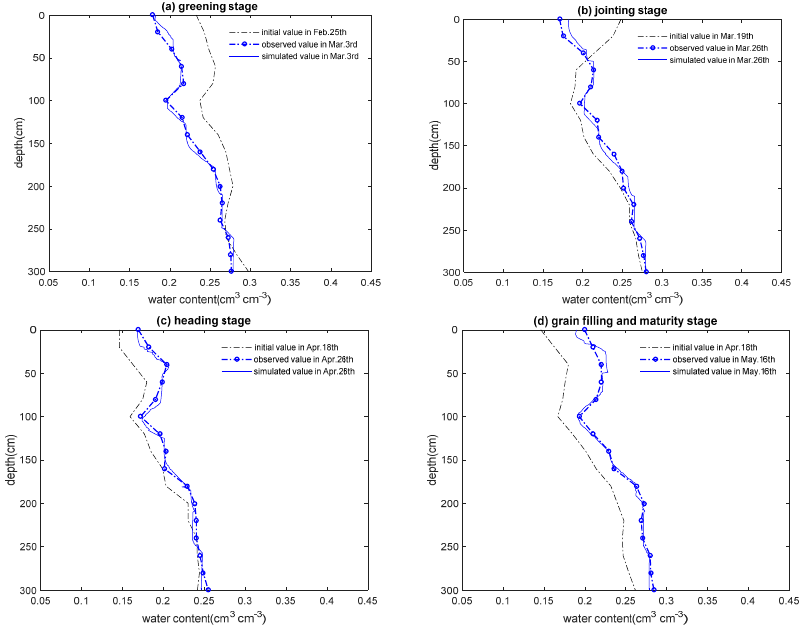
Figure 4. Comparison between simulated and observed values for soil water content in different stages of wheat growth.